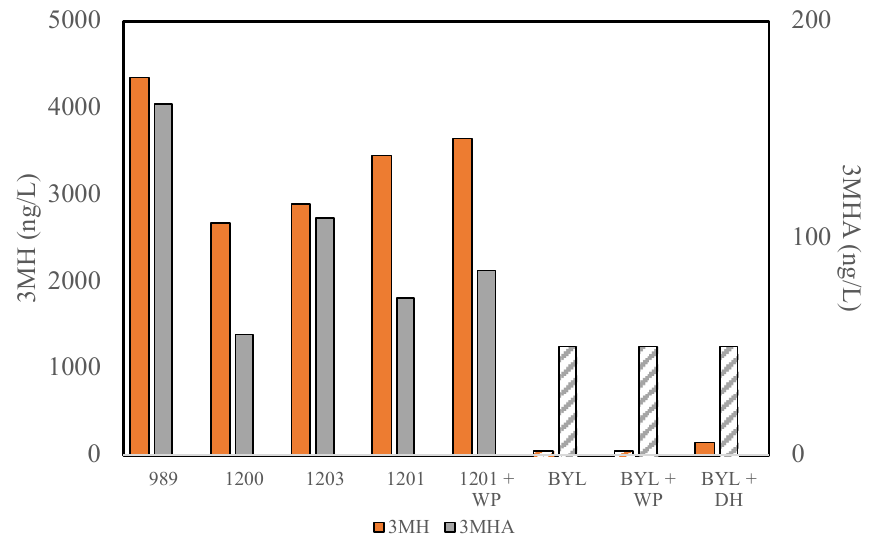
Figure 1. Thiol concentrations (ng/L) of 3MH and 3MHA in beer as a function yeast strain and hop treatment. Dashed columns represent the presence of either 3MH (orange) or 3MHA (gray) at concentrations below the quantification limit of 50 ng/L. Values represent averages of duplicate analyses where the coefficient of variation for all measurements averaged 4.2% (ranging from 0.2 to 11.9%).